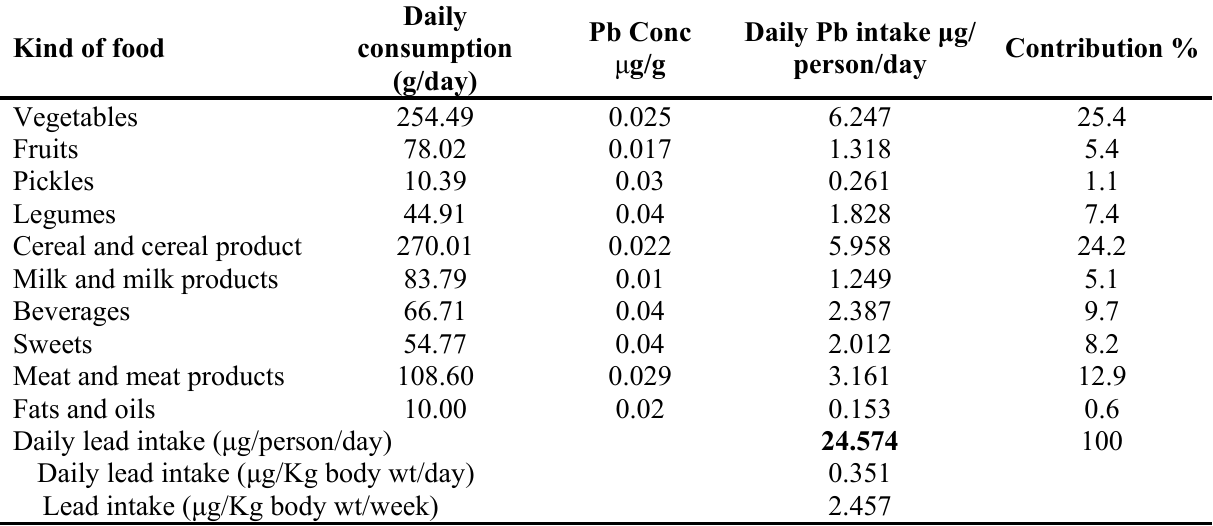
Table 2. Lead daily intake in correlation with the questionnaire.